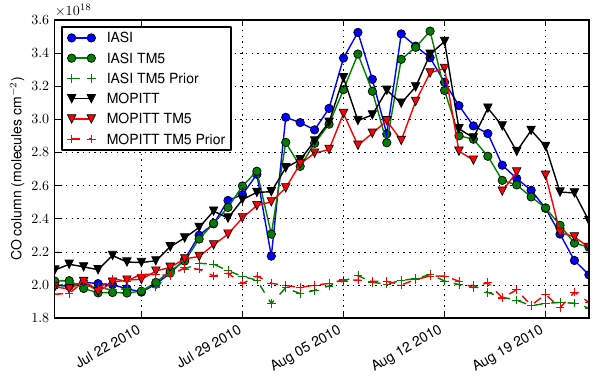
Fig. 2. Daily CO columns averaged over region R2 (see Fig. 1). The blue solid line refers to IASI, the green lines to model estimates co- sampled with IASI using prior MERGED emissions (dashed), and posterior MERGED emissions (solid). The dashed red line (MO- PITT TM5 prior) refers to the TM5 simulation with prior emissions co-sampled with non-assimilated MOPITT observations (black). The solid red line (MOPITT TM5) refers to the TM5 simulation with posterior emissions co-sampled with MOPITT observations.